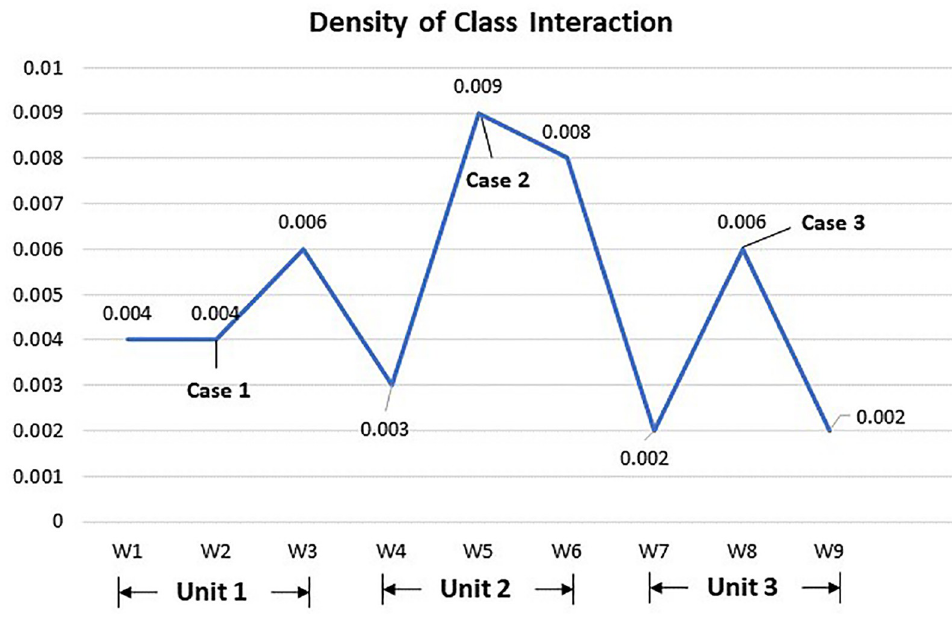
Fig 2. Density of class interaction in the discussion